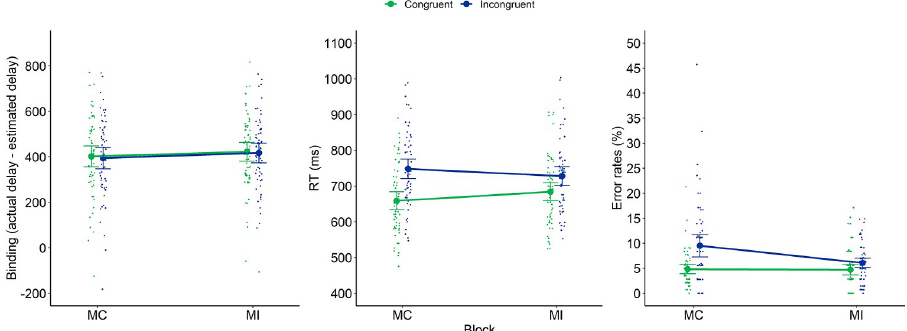
Fig 2. Intentional binding (left panel), RTs (middle panel) and error rates (right panel) of Experiment 1 as a function of previous congruency and current congruency. Dots represent mean RTs for each participant in each condition (thus, each participant is depicted four times on this graph, once for each Previous × Current Congruency condition). Error bars represent 95% confidence intervals.